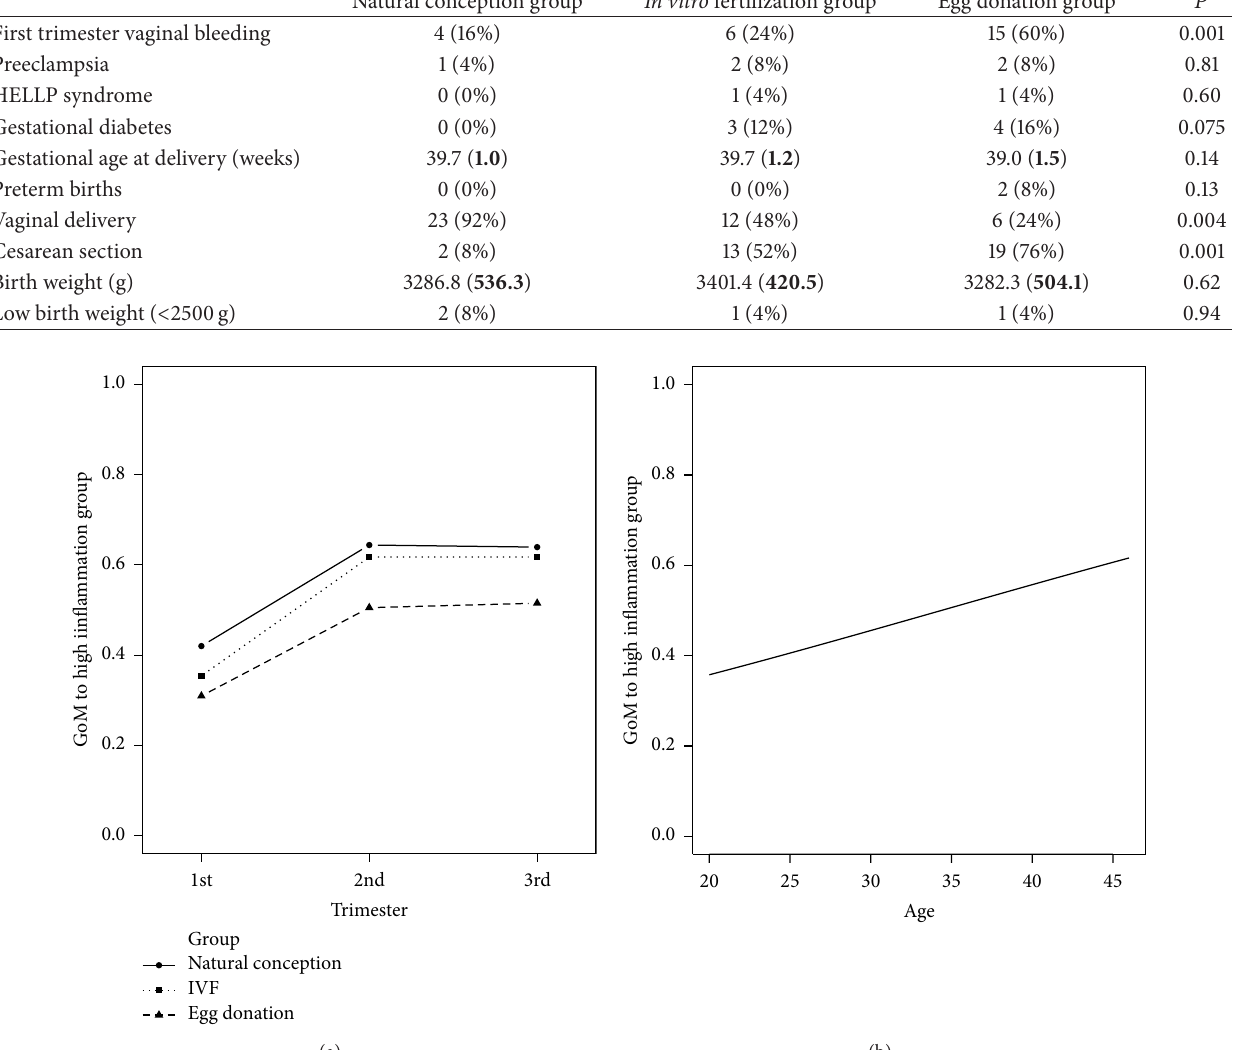
Table 3: Comparison of pregnancy outcome of the three study groups. Data expressed as 𝑁 (%) or mean (SD). Natural conception group In vitro fertilization group Egg donation group